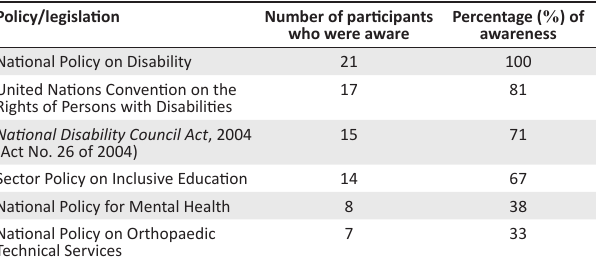
TABLE 3: Awareness on existence of disability-related policy and legislation in Namibia.